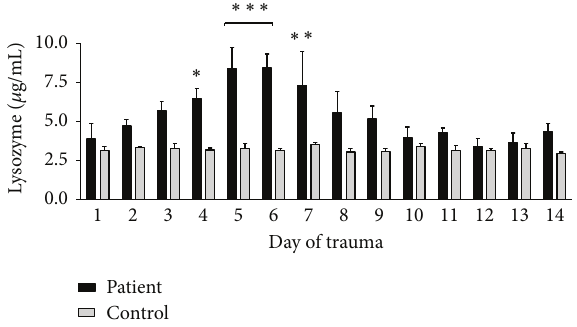
Figure 1: Elevated lysozyme levels in serum of multiply injured patients . Time course of serum concentration of lysozyme over a period of 14 days detected by ELISA. Significant elevated concen- tration of lysozyme can be shown between 4 and 7 days after trauma as compared to healthy controls; ∗∗∗ 𝑃 < 0.001 , ∗∗ 𝑃 < 0.01 , and ∗ 𝑃 < 0.5 .